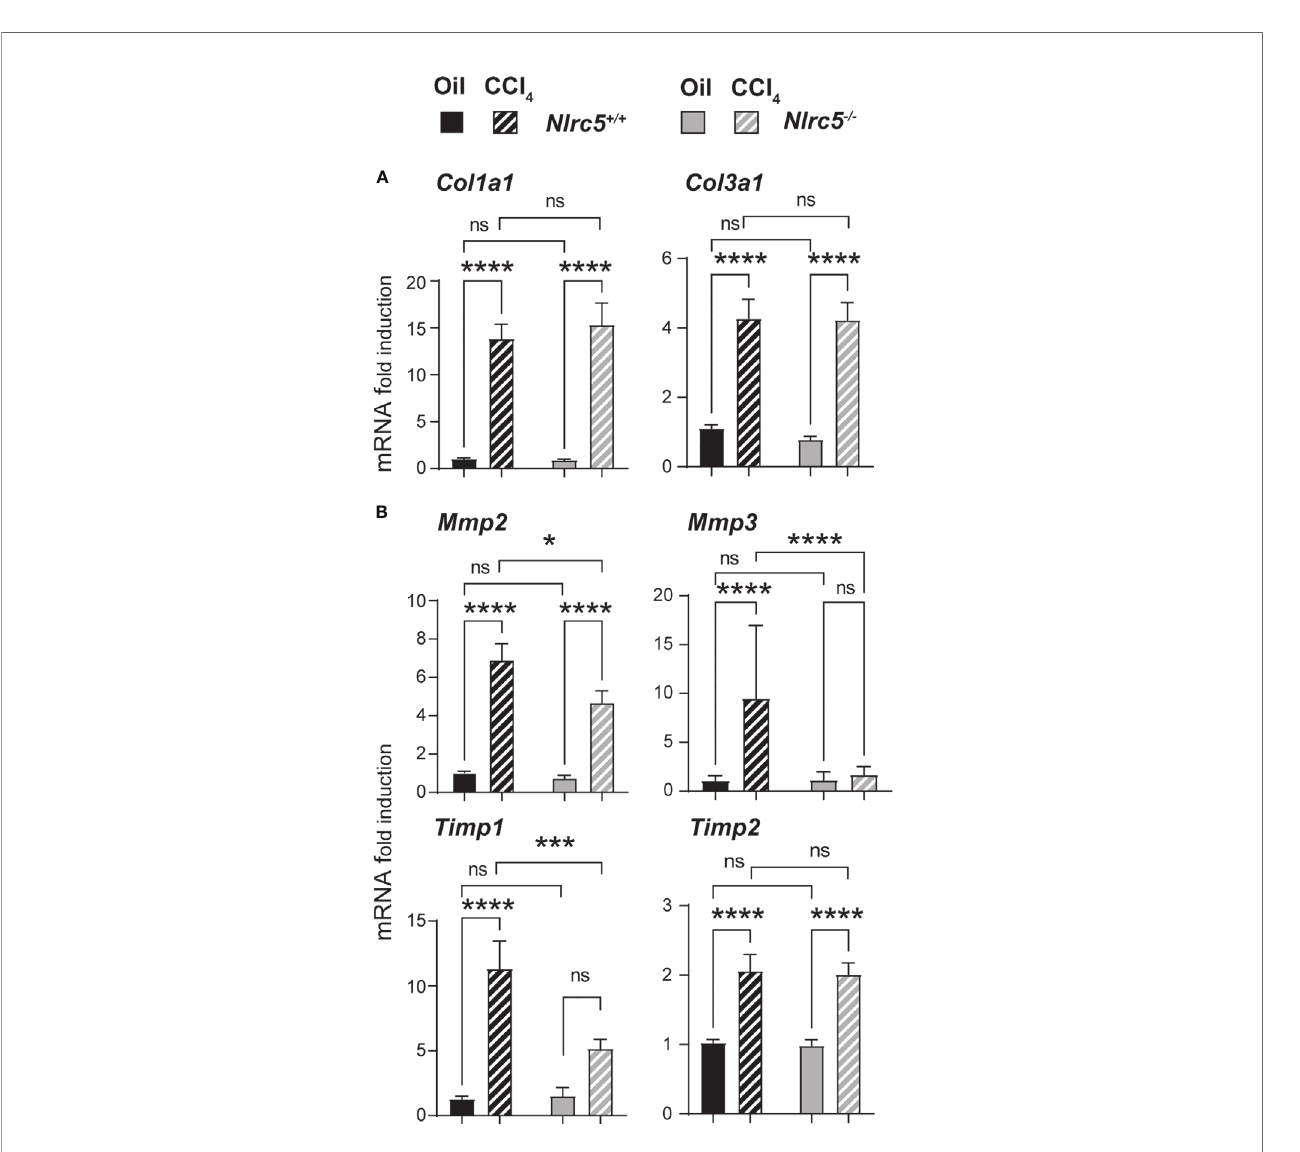
FIGURE 4 | Similar induction of collagens but differential induction ECM remodelling enzymes in NLRC5-de fi cient and control livers. RNA extracted from liver tissues from the indicated groups of mice were evaluated for the expression of (A) collagen ( Col1a1, Col3a1 ) and (B) ECM remodelling enzymes ( Mmp2, Mmp3, Timp1, Timp2 ) by qRT-PCR. Data shown are mean ± SEM; n= 6-10 mice for each group collected from 2-3 independent experiments. Two-way ANOVA with Tukey ’ s post- hoc test: *p < 0.05; ***p < 0.001; ****p < 0.0001; ns, not signi fi